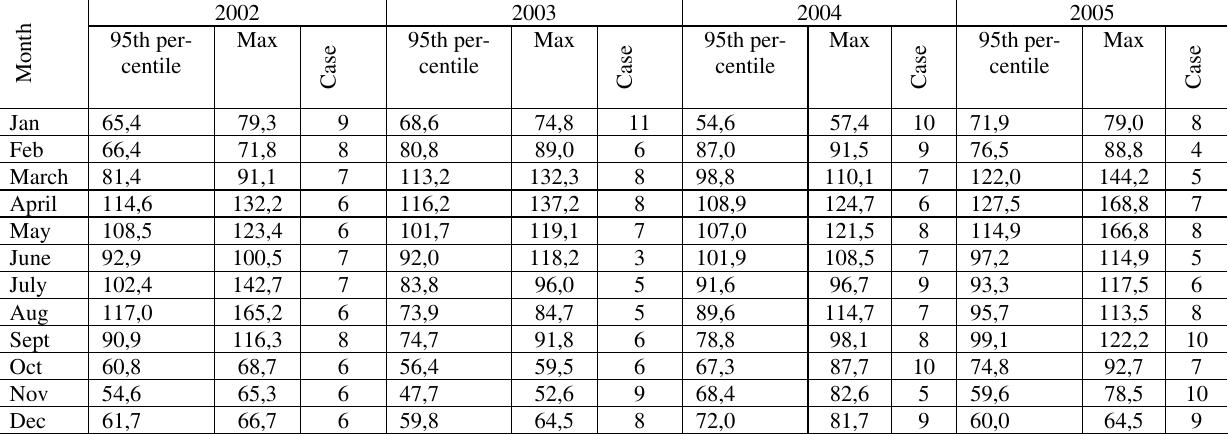
Table 3. The 95th percentile and maximum of ozone concentration in μ g/m 3 and the number of selected cases at R ū gštelišk ė s